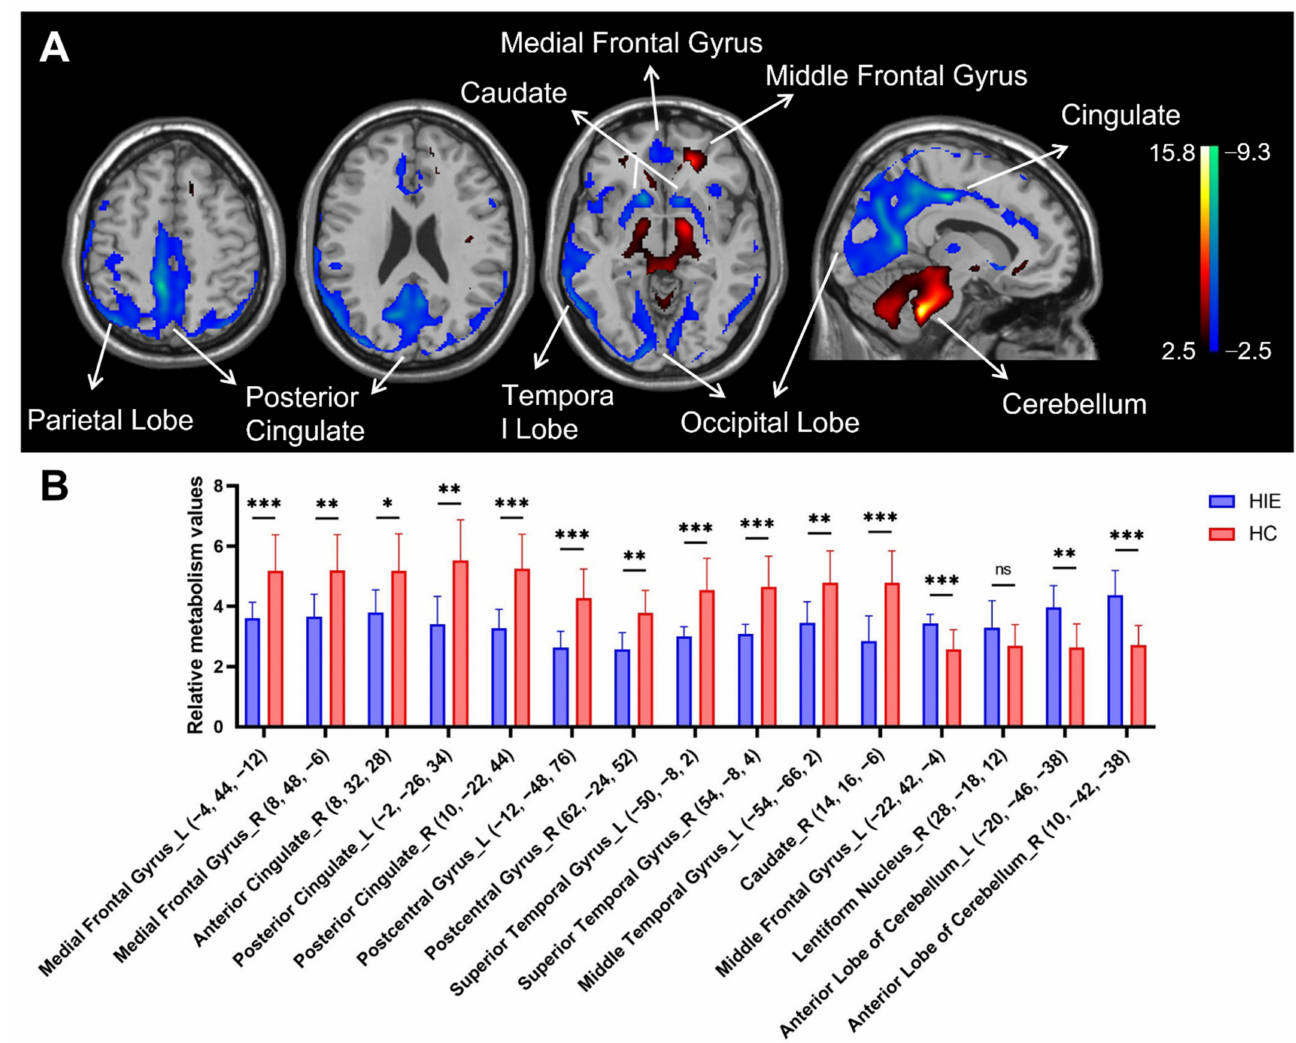
Figure 1. Brain regions with relative abnormal metabolism in patients with hypoxic ischemic en- cephalopathy (HIE) presenting with disorders of consciousness (DOC). ( A ) Normalized glucose metabolism in the HIE patients decreased (blue) bilaterally in the medial frontal gyrus, posterior cingulate gyrus (extending to parietal-occipital lobe), postcentral gyrus and superior temporal gyrus, and in the right anterior cingulate gyrus and right caudate nucleus, but increased (red) in bilateral anterior cerebellar lobe and left middle frontal gyrus and right lentiform nucleus relative to the healthy controls (HC). The overlays are depicted in neurologic orientation. The gray-scale image is a T1-weighted structural magnetic resonance imaging (MRI) that is representative of Montreal Neu- rological Institute (MNI) space. The thresholds of the color bars represent T values. ( B ) Differences in regional glucose metabolism in the HIE patients and HC subjects illustrated by post hoc values obtained within a spherical volume of interest (VOI) (3 mm radius) with the center coordinates of each VOI given in the parentheses. The graphs showed the relative metabolic value decreases in the bilateral medial frontal gyrus, posterior cingulate gyrus, postcentral gyrus and superior temporal gyrus, and right anterior cingulate gyrus and right caudate nucleus, while the relative metabolic value increases in bilateral anterior cerebellar lobe and left middle frontal gyrus. The error bars represent standard deviation. ns, no statistical difference. HIE, hypoxic ischemic encephalopathy. HC, healthy control. L, left. R, right. *, p < 0.05. **, p < 0.01, ***, p <